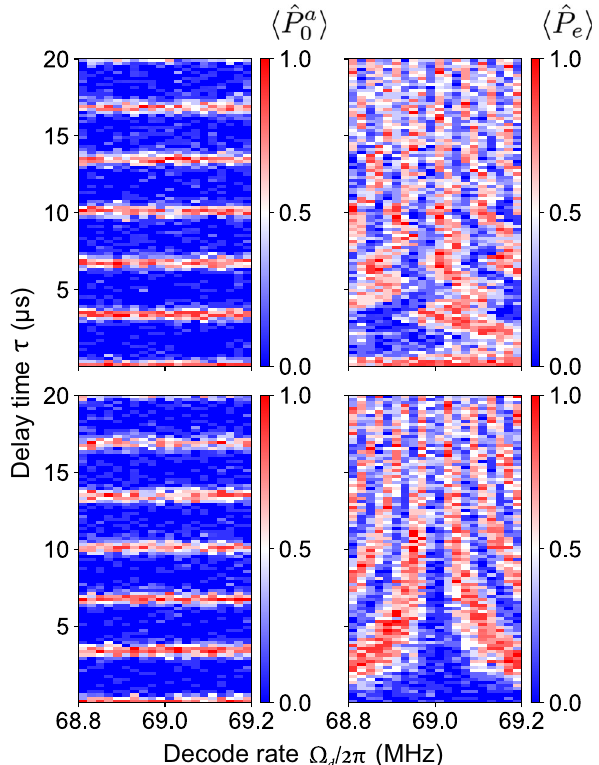
FIG. 11. Echoing away residual entanglement. Simultaneous measurement of the vacuum projector on the tuning mode via a ˆ H transmon ancilla (left) and the driven qubit (right) while is a active. The pulse sequence used for this calibration is shown in Fig. 10 without (top) and with (bottom) the π rotation and echo delay τ and only sidebands on the tuning mode. There is no ED initial displacement amplitude ( α 0 ¼ 0 ). Time dynamics of the tuning mode ’ s vacuum projector reveals coherent revivals as expected [as in Fig. 2(c) of the main text], independent of the decode rate on the driven qubit. Scanning the decode rate without the echo sequence results in distortions to the driven Ramsey data that are correlated with the cavity photon distribution. Imple- menting the echo sequence eliminates this effect, suggesting that the systems remain unentangled at all delay times. Here, we use 144 an optimized value of the delay time τ ED ¼